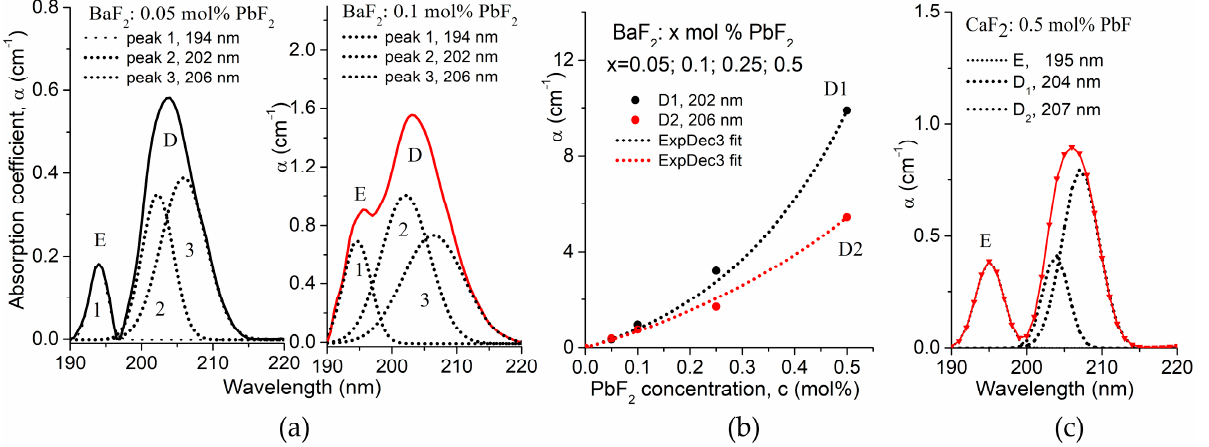
Figure 6. ( a ) Gaussian multi-peak fitting of the D band for two samples; ( b ) dependence of the D band component intensity on the PbF 2 concentration; ( c ) the D and E bands decomposed by Gaussian multi-peak fi tt ing of CaF 2 : 0.5 mol% PbF 2 .